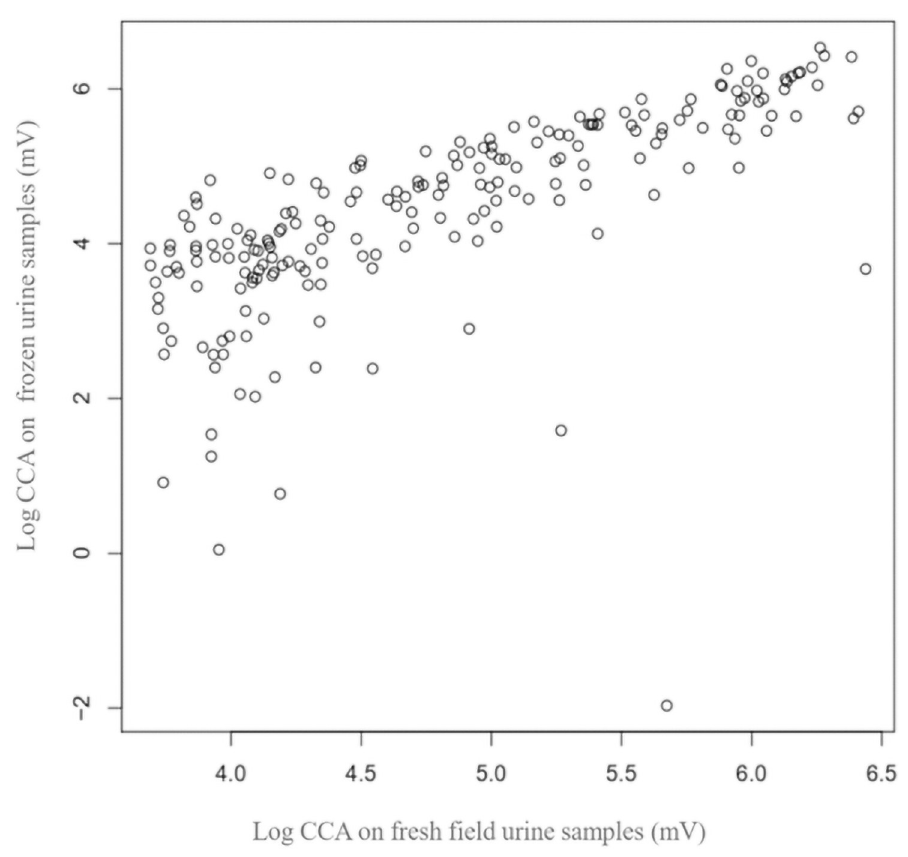
Fig 5. Correlation between infection intensity generated by the reader on frozen and fresh urine